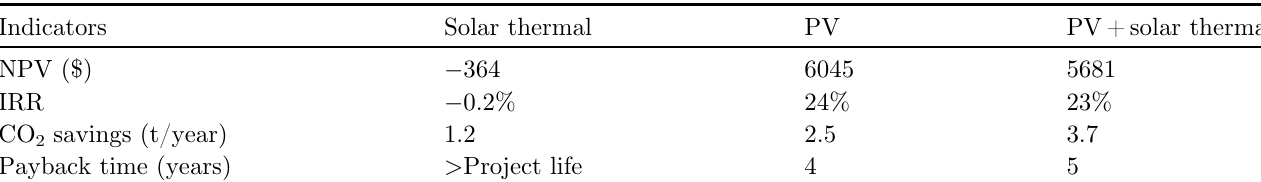
Table 4. Performance